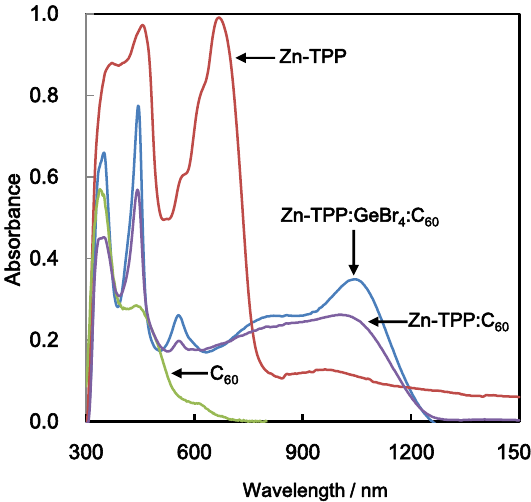
Figure 2. UV-vis absorptions of bulk heterojunction thin films of tetraphenyl porphyrin zinc (Zn-TPP) and C at weight ratio of 1:9 with insert of GeBr 60